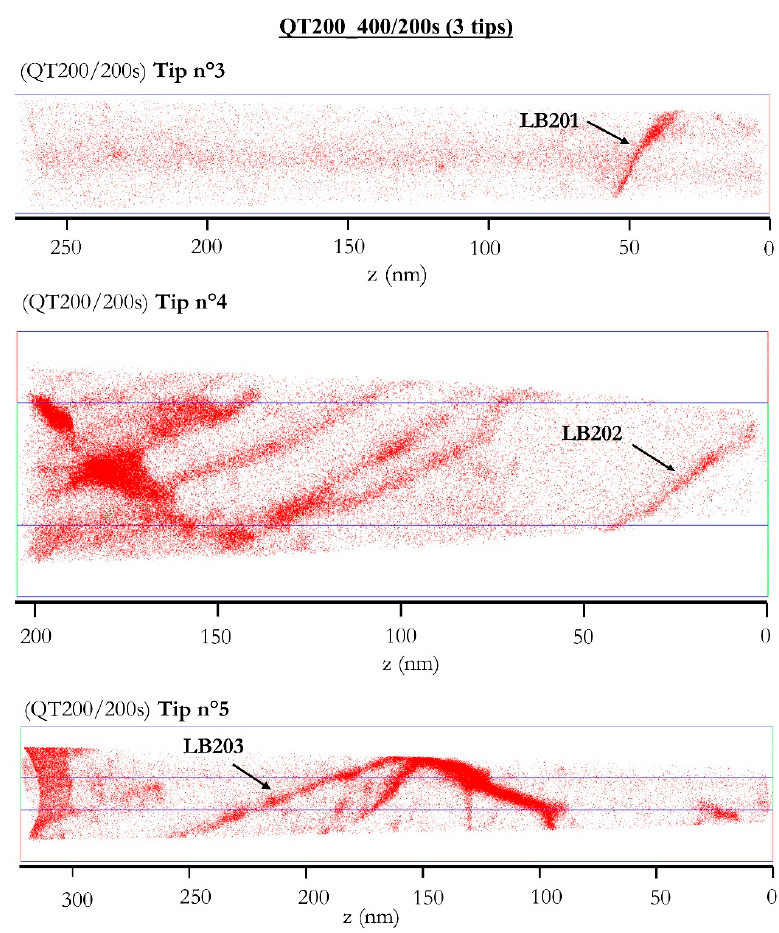
Figure20. Carbondistributionmapsinmartensiteshowingthreecarbonsegregationsonlathboundaries in tip n ◦ 4, tip n ◦ 5, and tip n ◦ 6 (LB201, LB202, and LB203) (QT200 PT / t = 400 ◦ C / 200